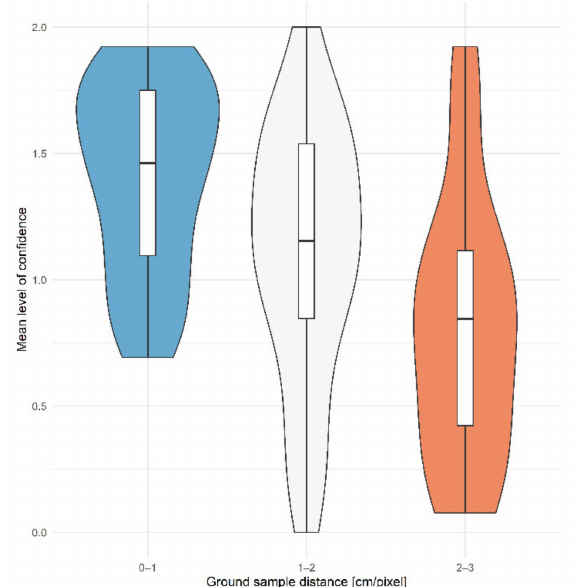
Figure 5. Effect of image resolution on the reviewers’ mean level of confidence (CNF_img). Columns and colours represent ground sample distances (GSD; cm/pixel). Column widths indicate the kernel probability density at the corresponding Y axis values. The boxes contained within columns represent interquartile ranges with markers for median